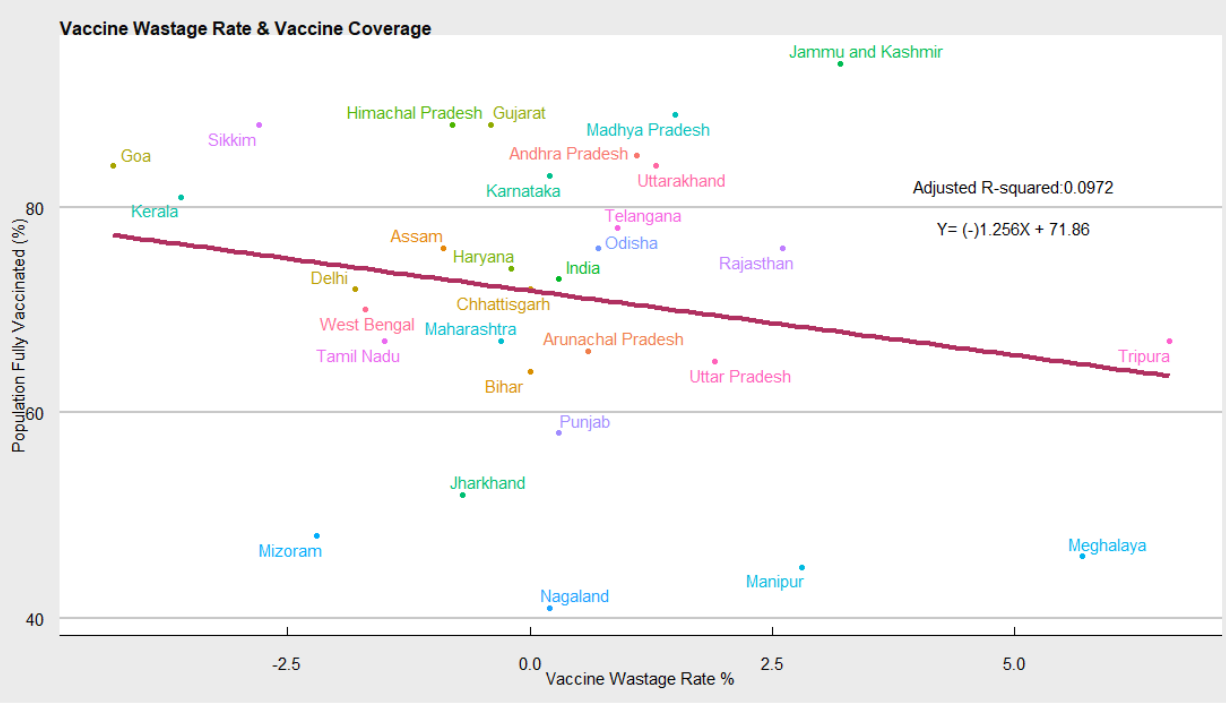
Figure 6. Scatter plot depicting vaccine wastage and COVID-19 vaccination